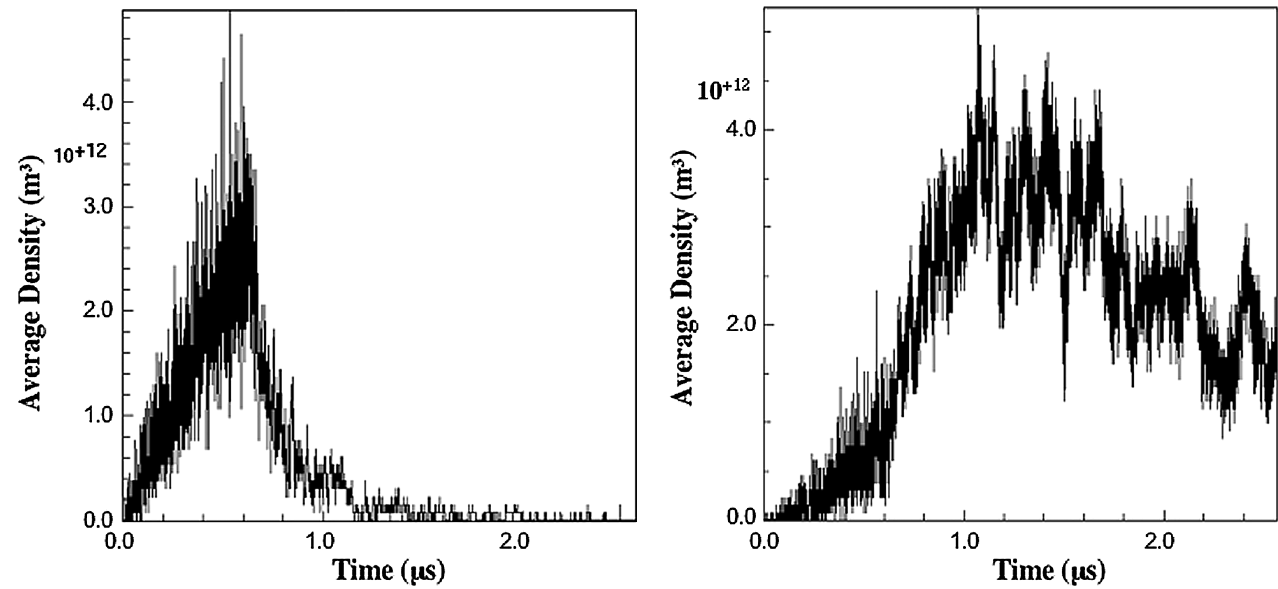
FIG. 10. Average electron density vs time within 1 mm of the chamber axis ( x ¼ y ¼ 0 ) vs time for z within 3.134 mm of the maximum of B y in the wiggler (left) and z at B y ¼ 0 (right) for a 45-bunch train. Fluctuations are due to macroparticle statistics within this small volume.